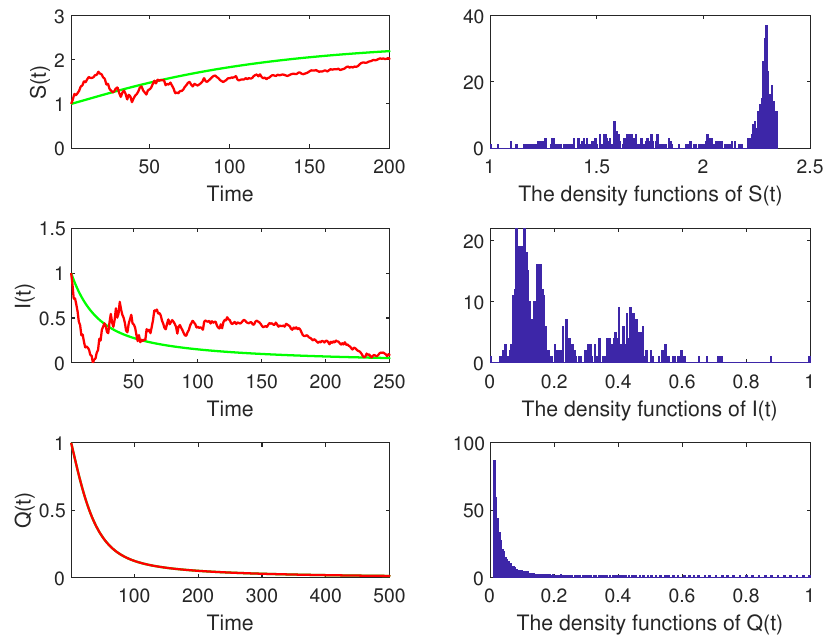
Figure 2. The red lines discribe the solution of system (3) and the green lines stand for the solution of the corresponding system (2). The right pictures are the histogram of the density function for S , I , and Q